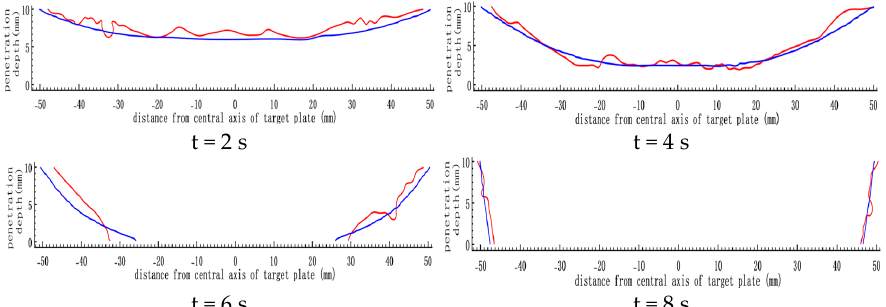
Figure 17. Comparison of theoretical calculation and simulation results. (The blue and red lines are the fitting and testing results, respectively.) The time-vary- ing melting hole shape obtained by the theoretical calculation was highly consistent with that of the simulation, which proved that the theoretical model had high accuracy.